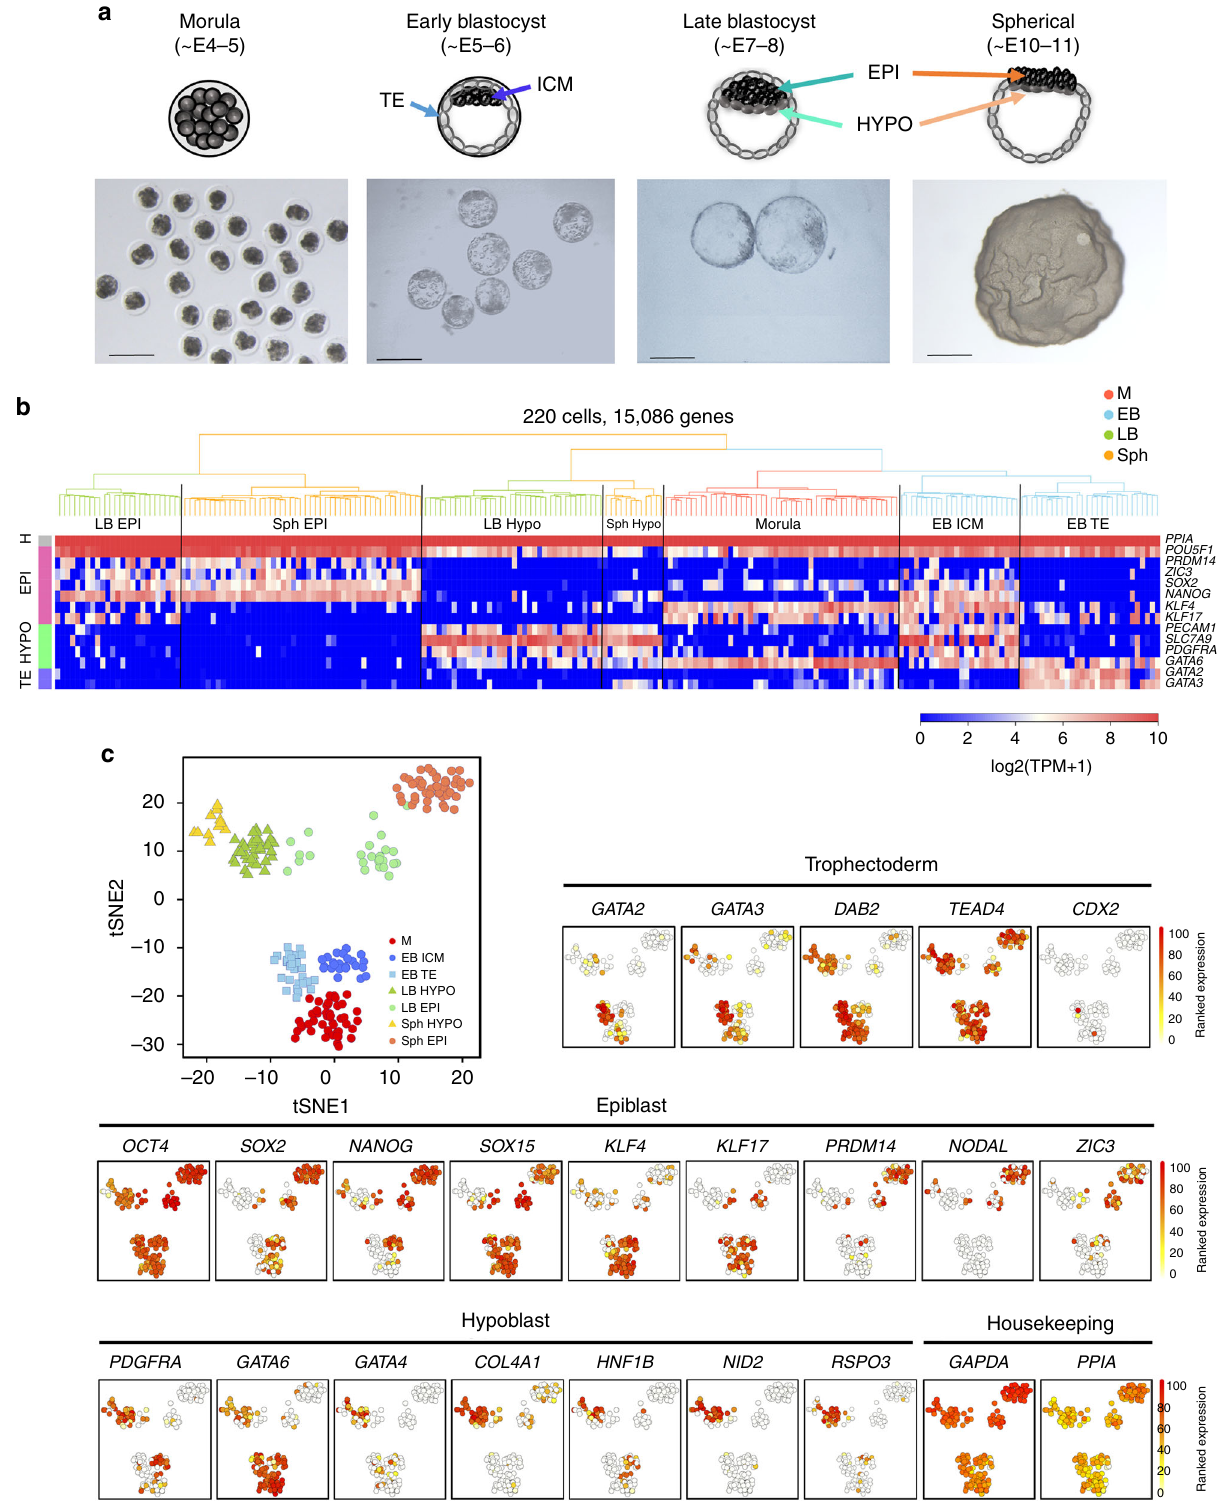
Fig. 1 Lineage segregation in pig pre-implantation embryos. a Pig pre-implantation embryos collected for scRNA-Seq. b Unsupervised hierarchical clustering (UHC) with all expressed genes (15,086 genes), with a heat map of expression levels of lineage-speci fi c markers. Colours in dendrogram indicate developmental stage. c t-SNE plot of all cells, indicated by colours and shapes for different embryonic days and lineages. Lineage-speci fi c genes are shown in t-SNE plots; a gradient from white to red indicates low to high expression. n = 220 cells. E: embryonic day, M: morula, EB: early blastocyst, LB: late blastocyst, Sph: spherical embryo, EPI: epiblast, HYPO: hypoblast, ICM: inner cell mass, TE: trophectoderm. Scale bar: 300 µ